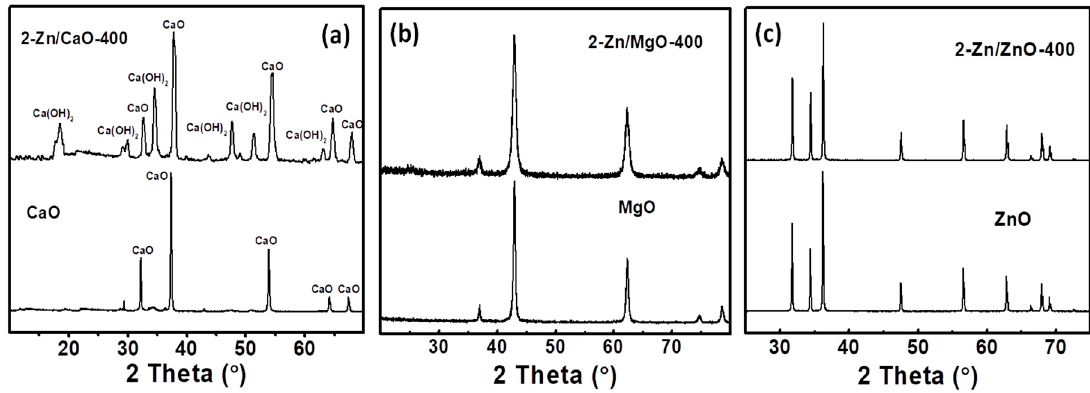
Figure 1. Comparative powder XRD patterns of ( a ) CaO with 2-Zn/CaO-400, ( b ) MgO with 2-Zn/MgO-400, and ( c ) ZnO with 2-Zn/ZnO-400. 2-Zn / MgO-400, and ( c ) ZnO with 2-Zn /